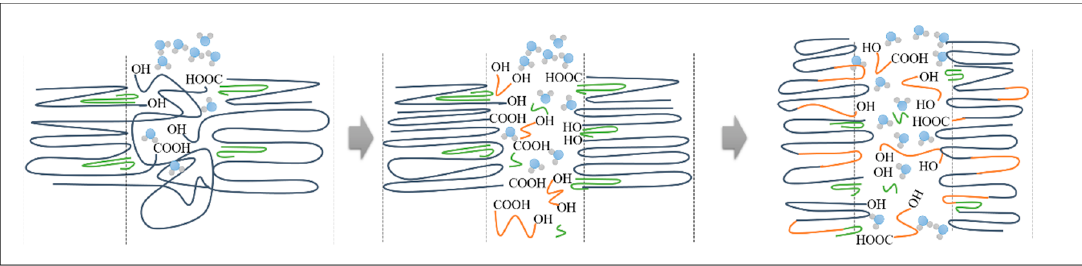
Figure 9. Schematic representation of the hydrolysis process in the amorphous and crystalline regions. Long PLA chains are represented with blue lines, short PLA chains are in orange, and OLA is represented in green.